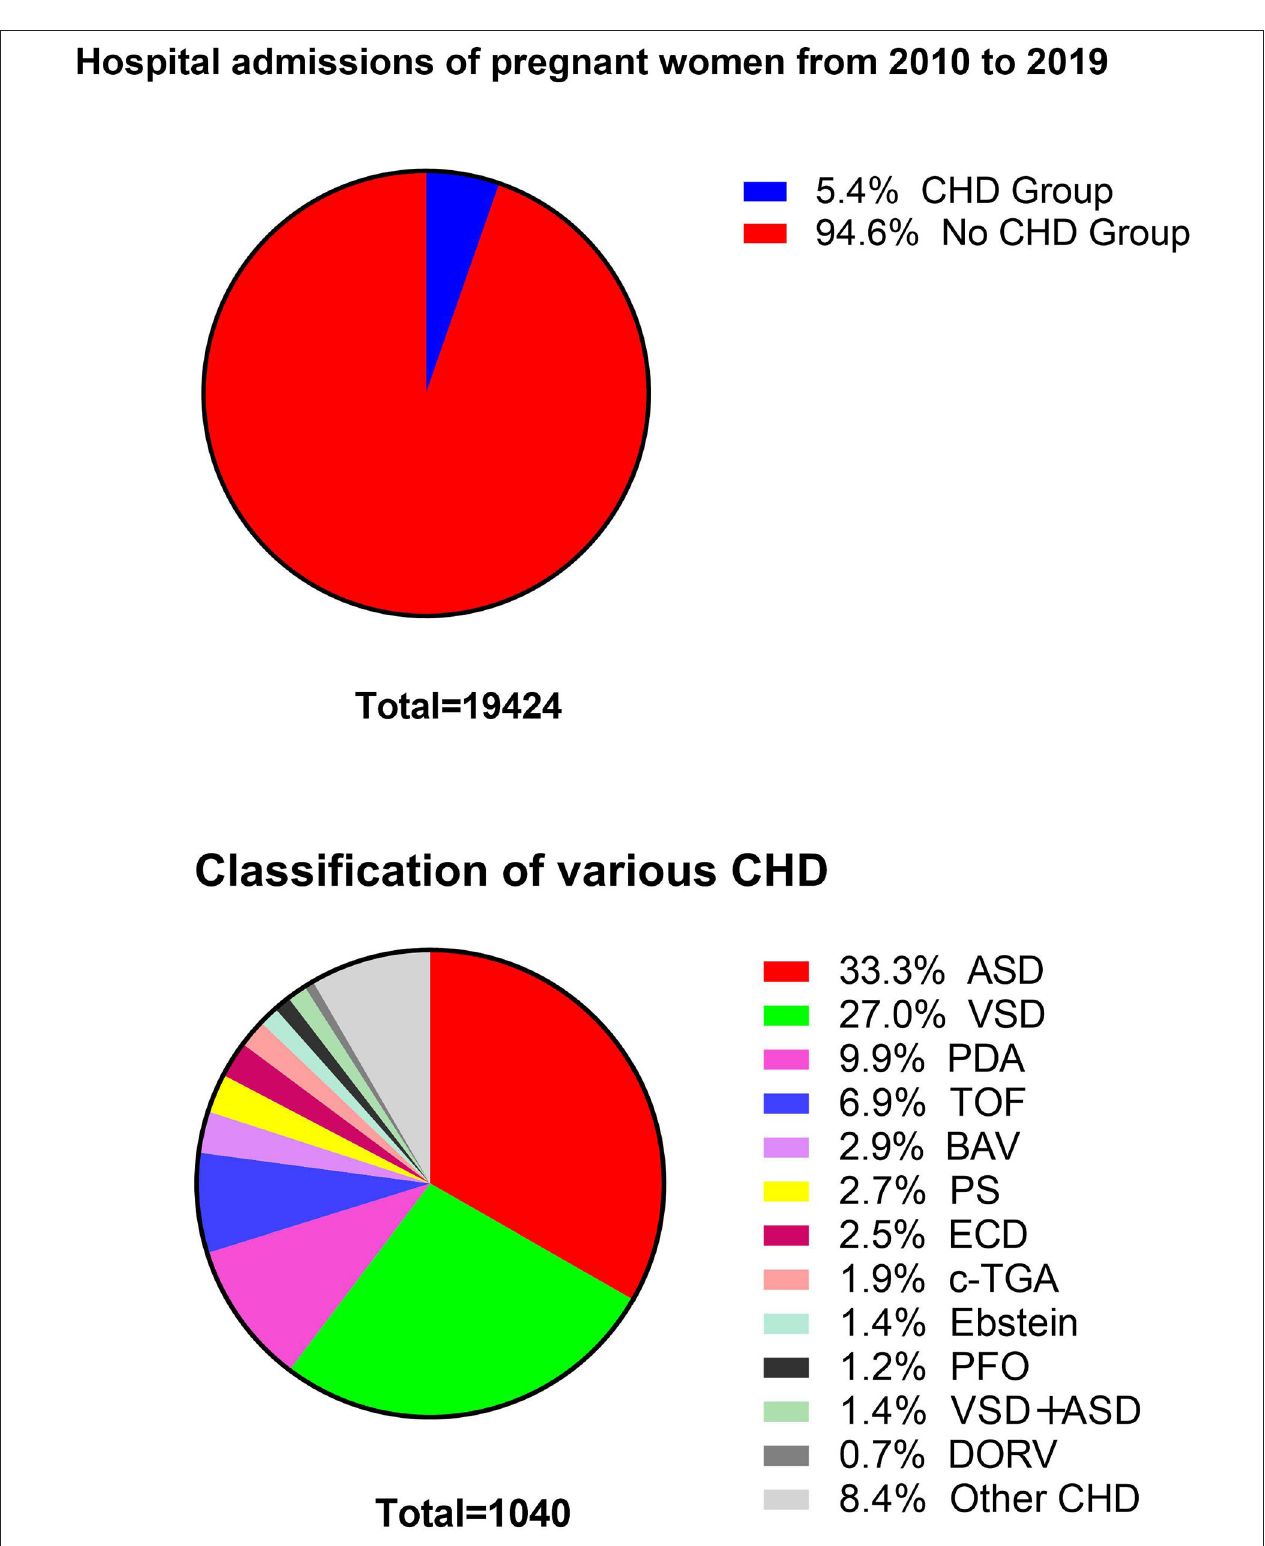
FIGURE 2 | Total number of pregnant women in Beijing Anzhen Hospital from 2010 to 2019, and the percentage of each CHD.